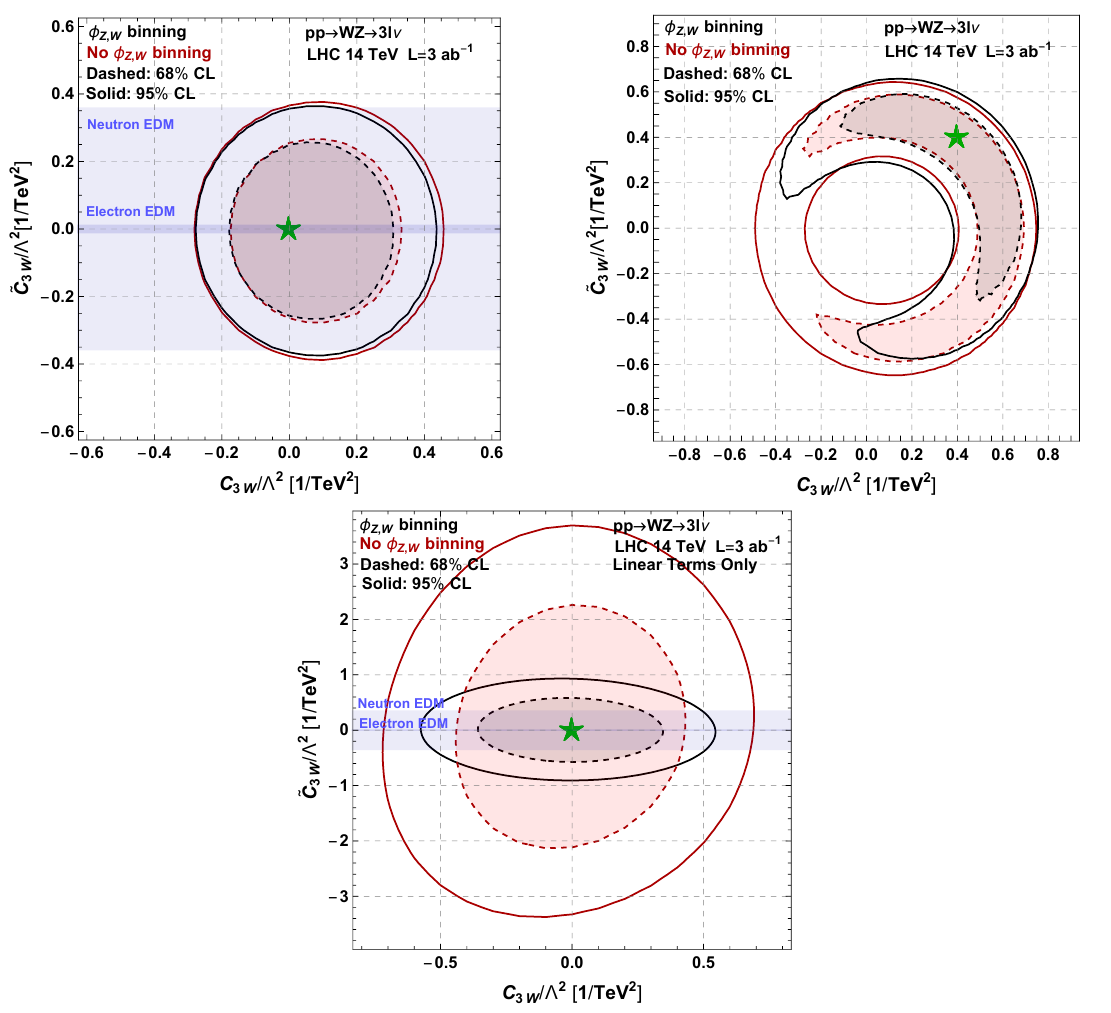
Figure 5 . 68% (dashed) and 95% (solid) posterior probability contours for the analysis with (black) and without (red) the binning in the (cid:30) Z and (cid:30) W angles, see main text for more details. The left and right hand upper plots are obtained assuming the SM and a BSM signal with c 3 W = ~ c 3 W = 0 : 4, both represented by a green star. The light and dark shaded blue correspond to the limits obtained by the non observation of a neutron and electron EDM discussed in section 5. On the lower plot for illustration purposes we present the exclusion contours assuming only the linear terms in the EFT expansion. Only events with m T < 1 : 5 TeV are WZ